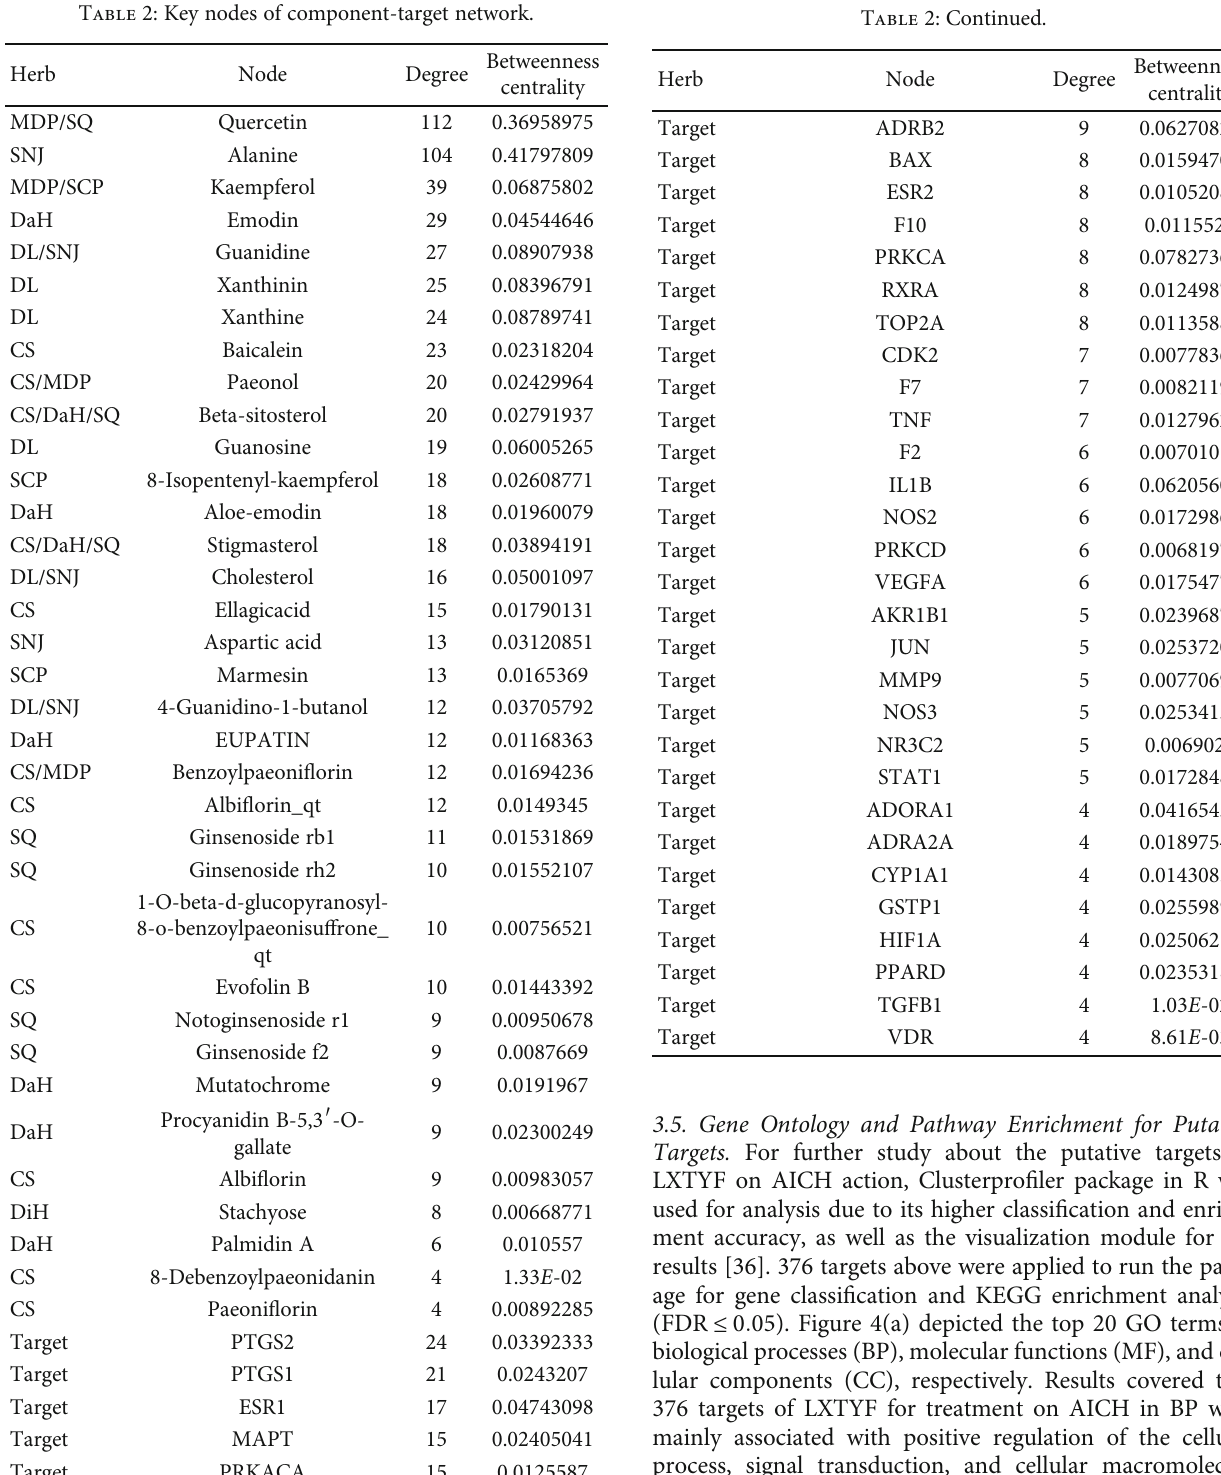
Table 2: Key nodes of component-target